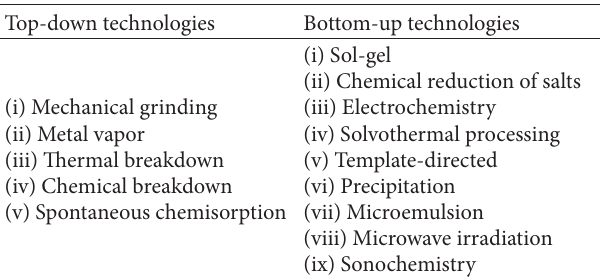
Table 1: Overview of top-down and bottom-up approaches used